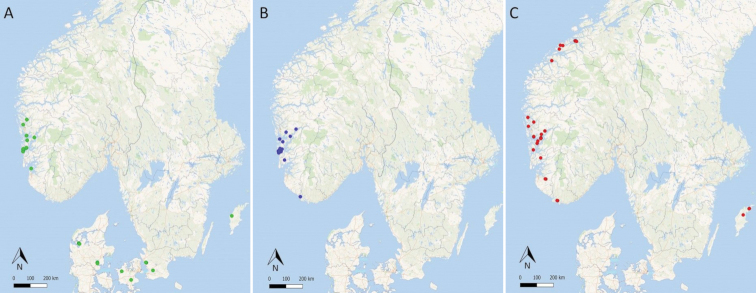
The distribution of 111 specimens of Coniocarpon in Norway, Sweden and Denmark based on material in BG, C, S, TRH and UPS. AC.
cinnabarinumBC.
cuspidansCC.
fallax. Single dots may represent several collections.